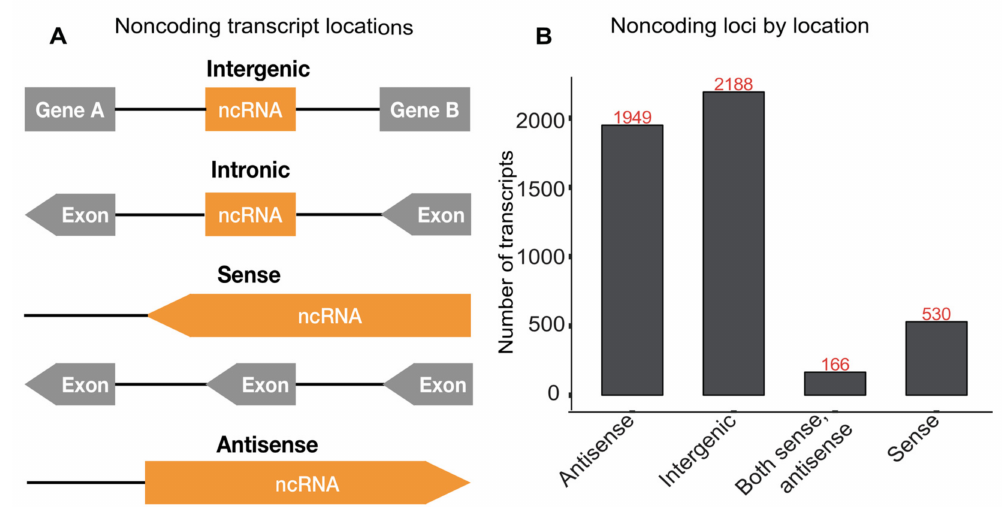
Figure 2. Location of noncoding transcripts. ( A ) Schematic representation of possible locations of noncoding transcripts relative to coding genes. ( B ) Bar graph showing the number of noncoding transcripts at the indicated genomic